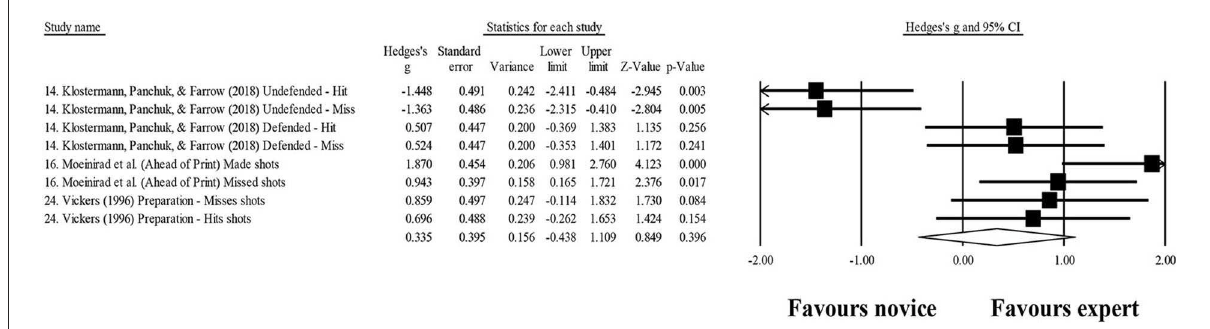
FIGURE10 Quiet eye duration: similar quiet eye duration was noted for expert athletes compared to novice athletes. Black squares: individual studies. Its size represents their relative weights. White rhomboid: summary value.